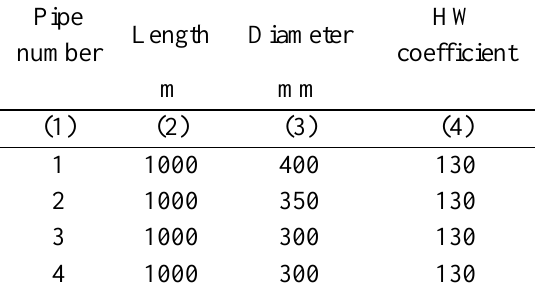
Table 1. Pipe data for illustrative example